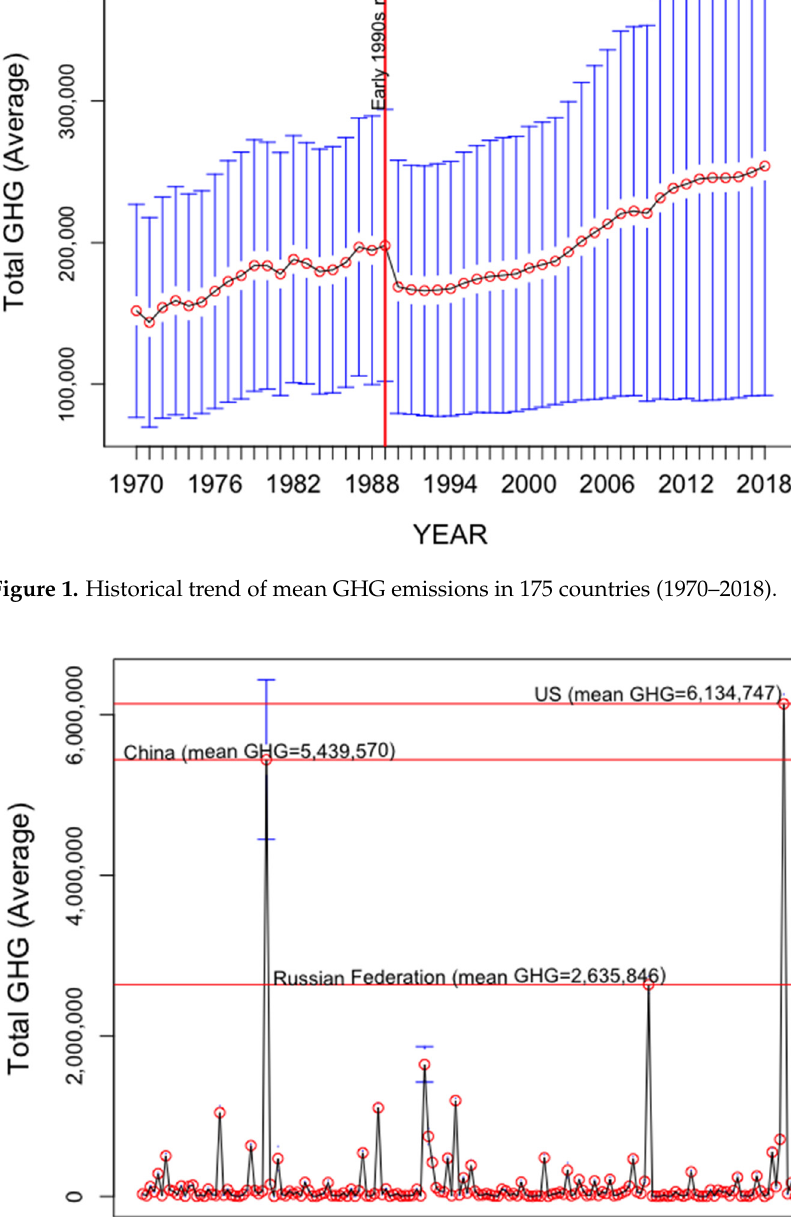
Figure 2. Mean GHG emissions per country over 1970–2018 (175 countries).